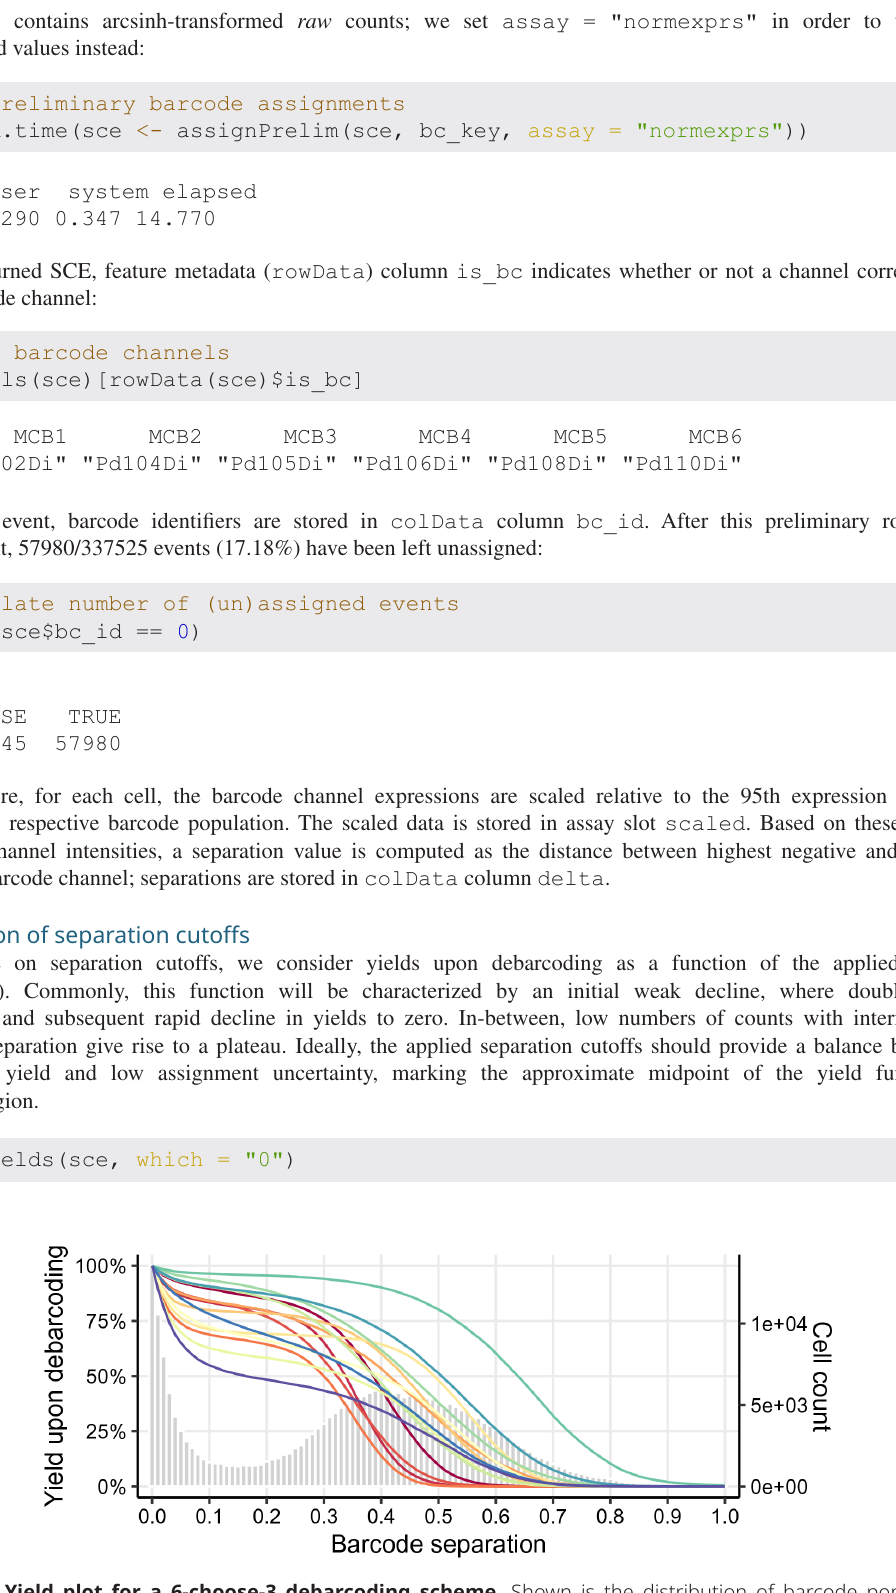
Figure 6. Yield plot for a 6-choose-3 debarcoding scheme. Shown is the distribution of barcode population separations (histogram) and cell yields by sample (lines) as a function of the applied separation cutoff. Left axis corresponds to cell yield in percent; right axis to the total number of